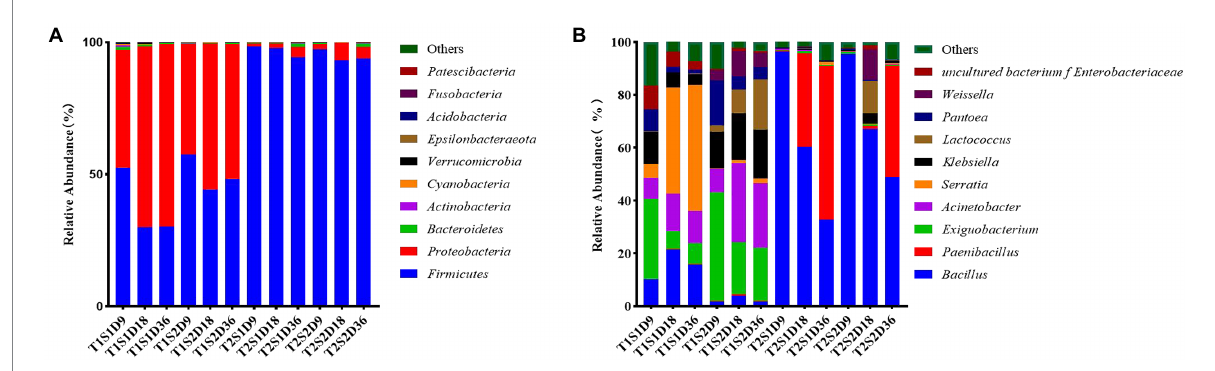
FIGURE. 1 Relative abundances of species Pennisetum sinese at the phylum level (A) and at the genus level (B) after fermentation of at different temperatures and sugar concentrations. T1, 25 ° C; T2, 45 ° C; S1, 0.4 g; S2, 1.6 g; D9, 9 h; D18, 18 h; D36, 36